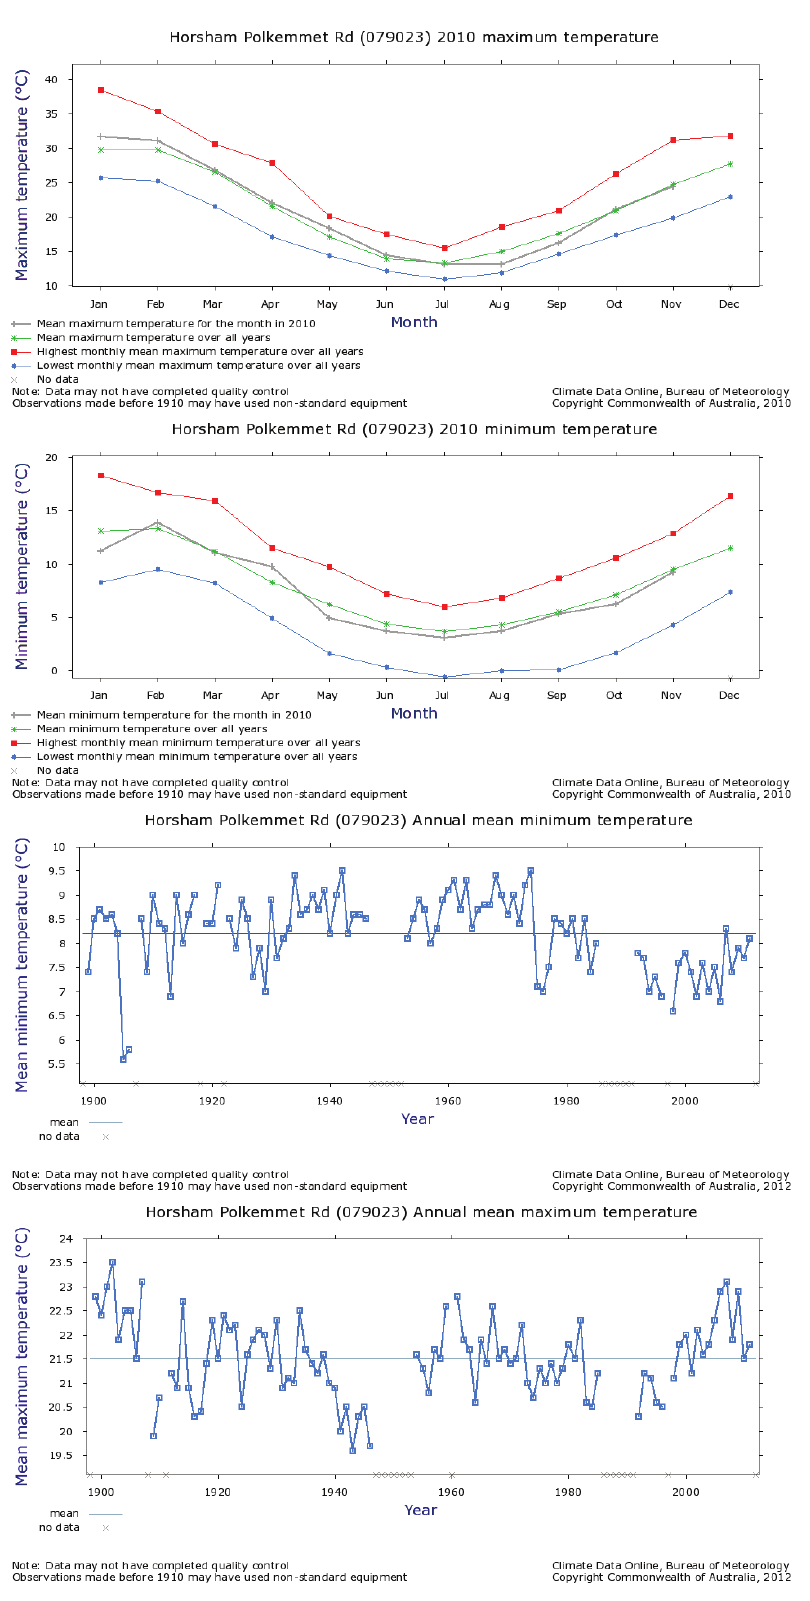
Figure 8. Australian Government Bureau of Meteorology temperature graphs for historical locations in Victoria, Aus-